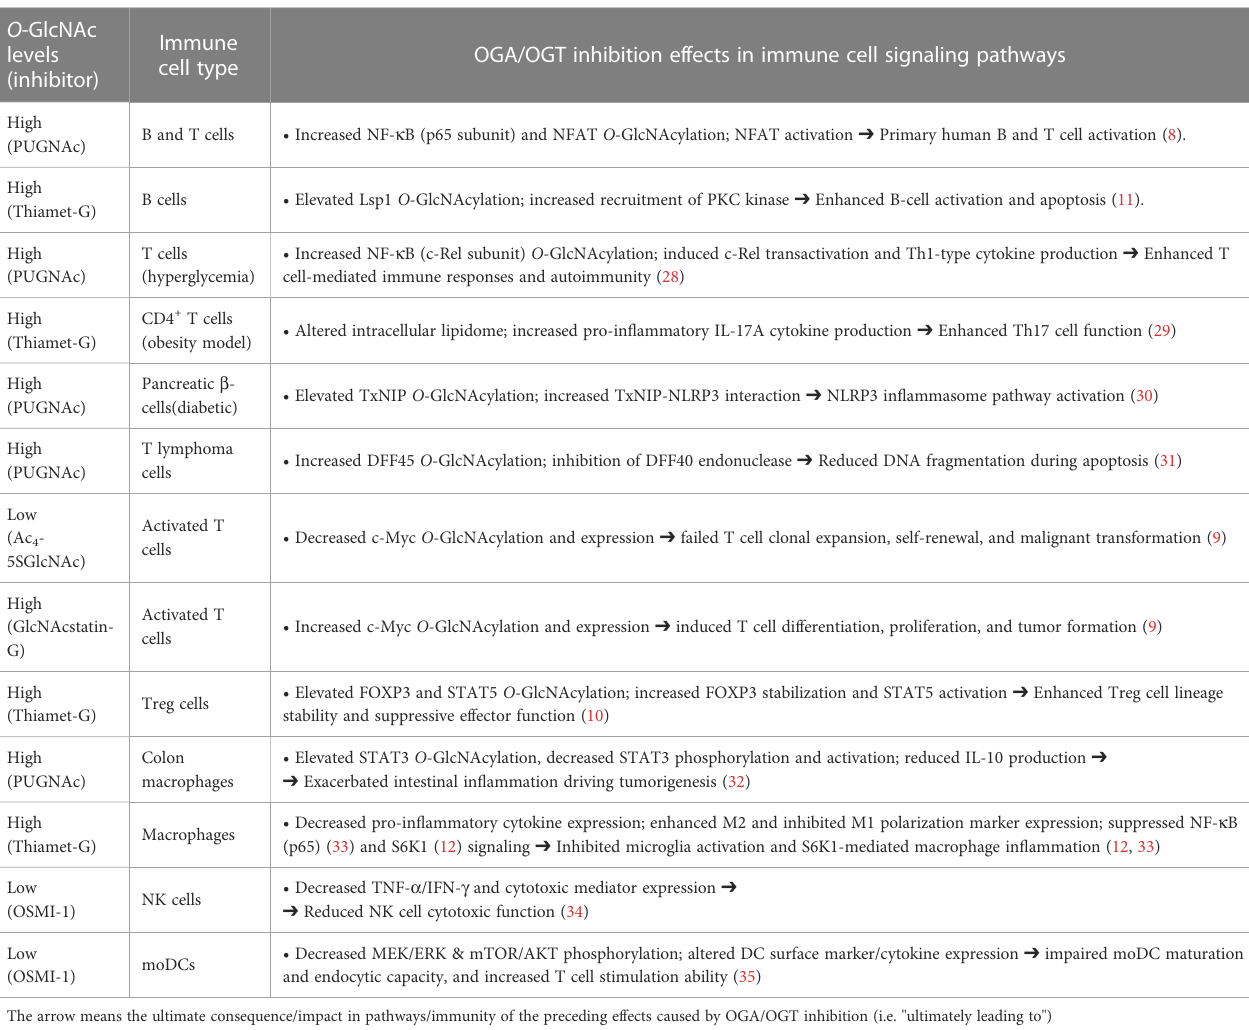
TABLE 2 Effect of OGA and OGT pharmacological inhibition in immune cell signaling